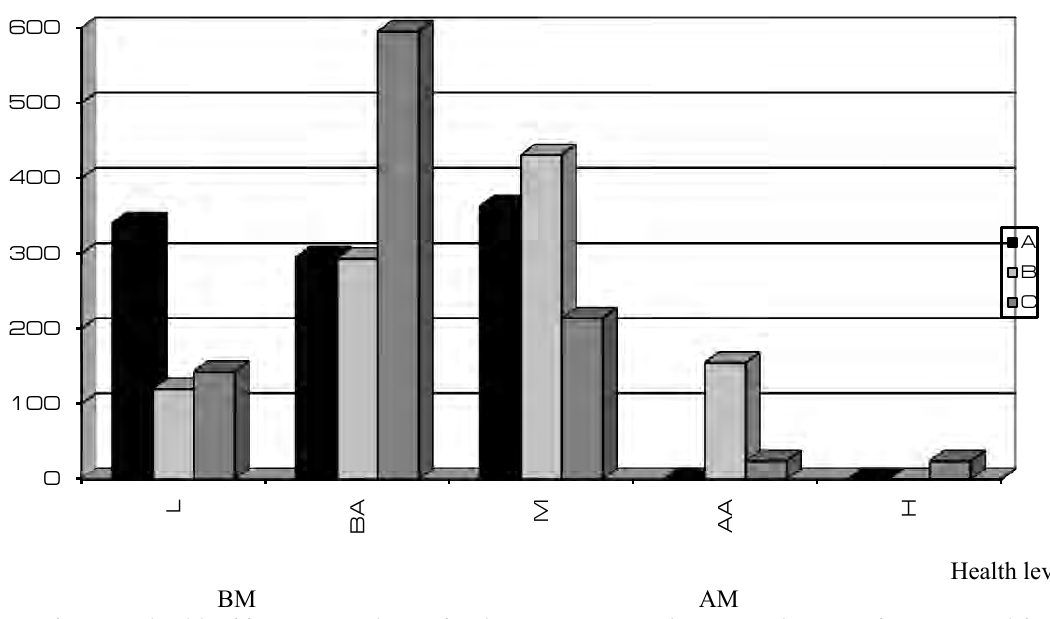
Fig.1. State of somatic health of first year students of pedagogic university by main indicators of organism’s life- functioning (by methodic of G.L. Apanasenko,